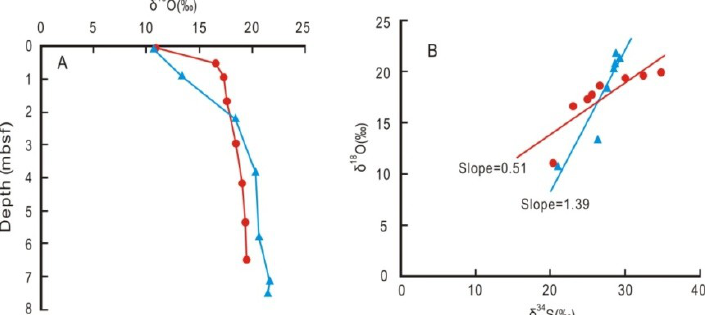
vs. δ 34 S data in SO4 SO4 values were taken from Luo et al. SO4